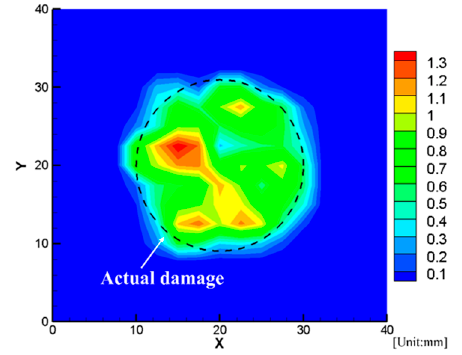
Figure 15. Reconstructed delamination images.